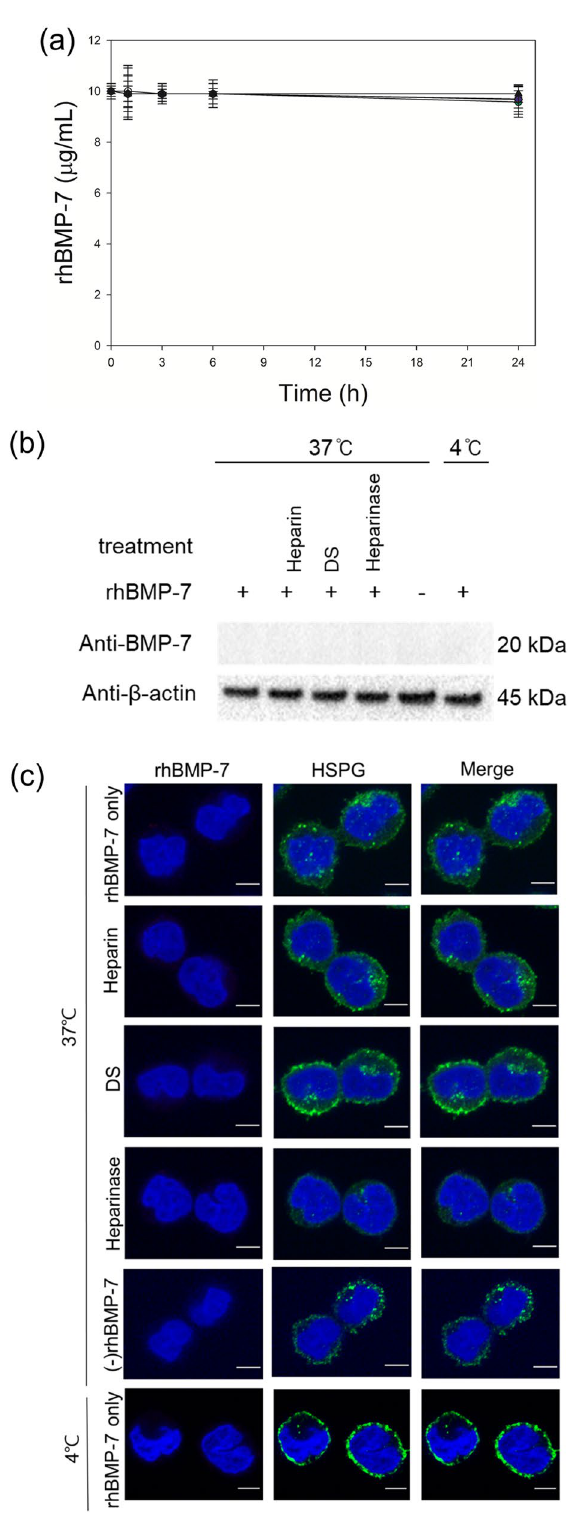
Figure 2. No internalization of rhBMP-7 in DG44 cells. ( a ) Profiles of rhBMP-7 during incubation with and without cells. With cells at 37 °C in the absence of heparin and DS (white circle), with cells at 37 °C in the presence of 0.1 g/L heparin (blue diamond) or 0.5 g/L DS (red diamond), with cells at 4 °C in the absence of heparin and DS (green circle), without cells in the absence of heparin and DS at 37 °C (white triangle) or 4 °C (black triangle). The error bars represent standard deviations calculated from six independent experiments. ( b ) Western blot analysis of intracellular rhBMP-7 at 37 °C or 4 °C. ‘ + ’ and ‘−’ indicate presence and absence, respectively. ‘Heparinase’ indicates cells pretreated with heparinase I/III. β actin was used as the loading control. ( c ) Confocal microscopy to examine the intracellular location of rhBMP-7. Intracellular rhBMP-7 was stained red, while HSPGs were stained green. The nuclei were stained blue. The merge images indicate co-localization (yellow) of rhBMP-7 and HSPGs. Scale bar 5